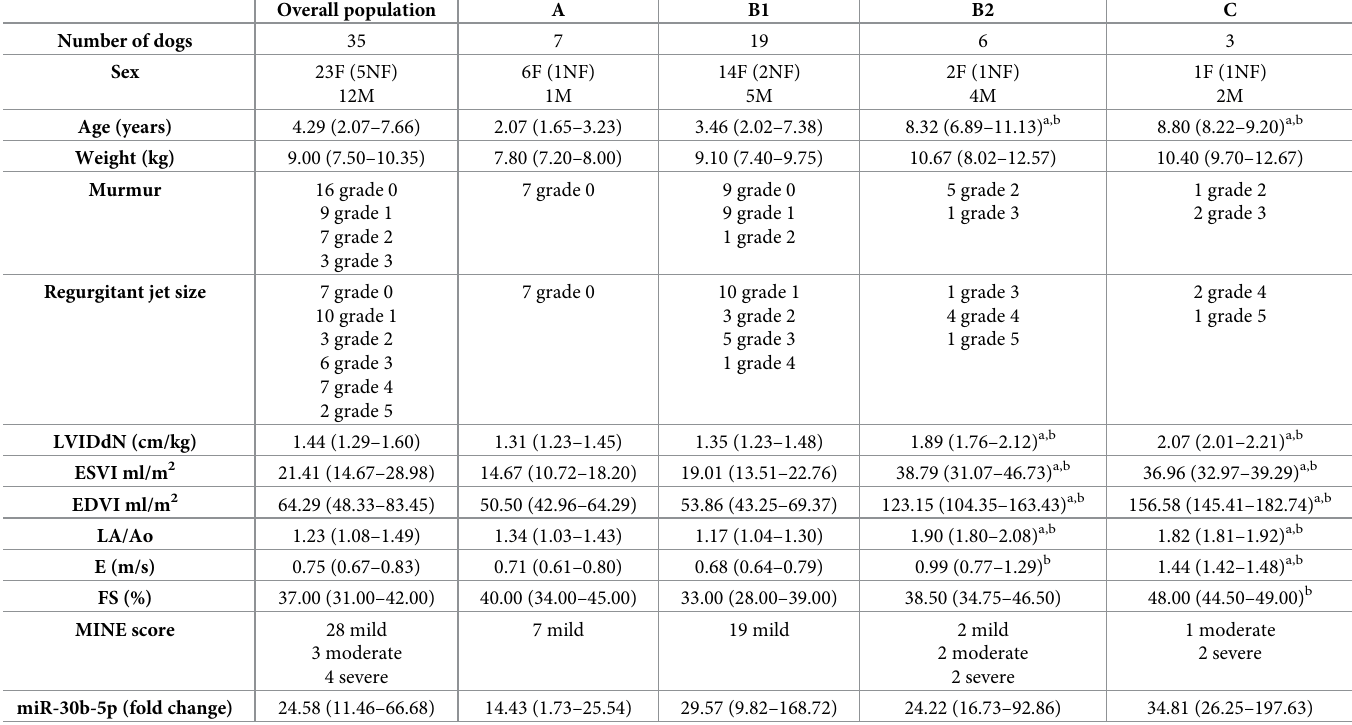
Table 2. Clinical and echocardiographic data, and plasma miR-30b-5p expression of the CKCS population divided according to the ACVIM classification scheme. Data obtained at T0. Overall population A B2